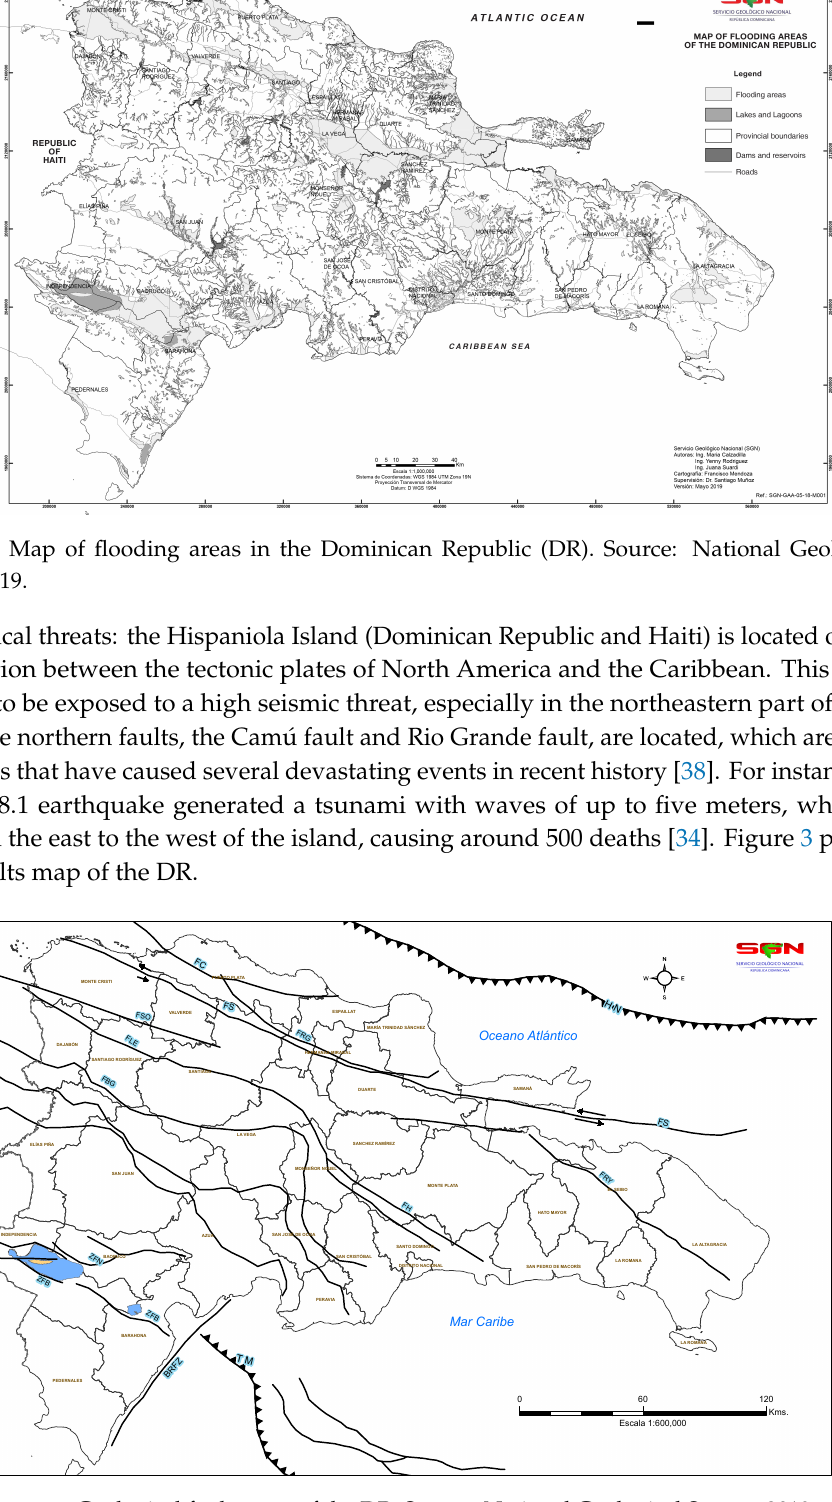
Figure 3. Geological faults map of the DR. Source: National Geological Survey,